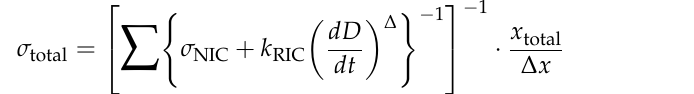
Figure 6. The dose rate distributions of the proton irradiated PI samples calculated using TRIM.